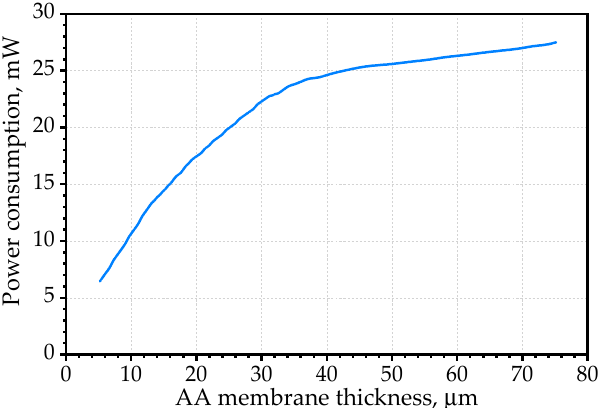
Figure 7. Dependence of the power consumption on the thickness of the gas-sensitive layer membrane with a porosity of about 20% at temperature of 500 °C.